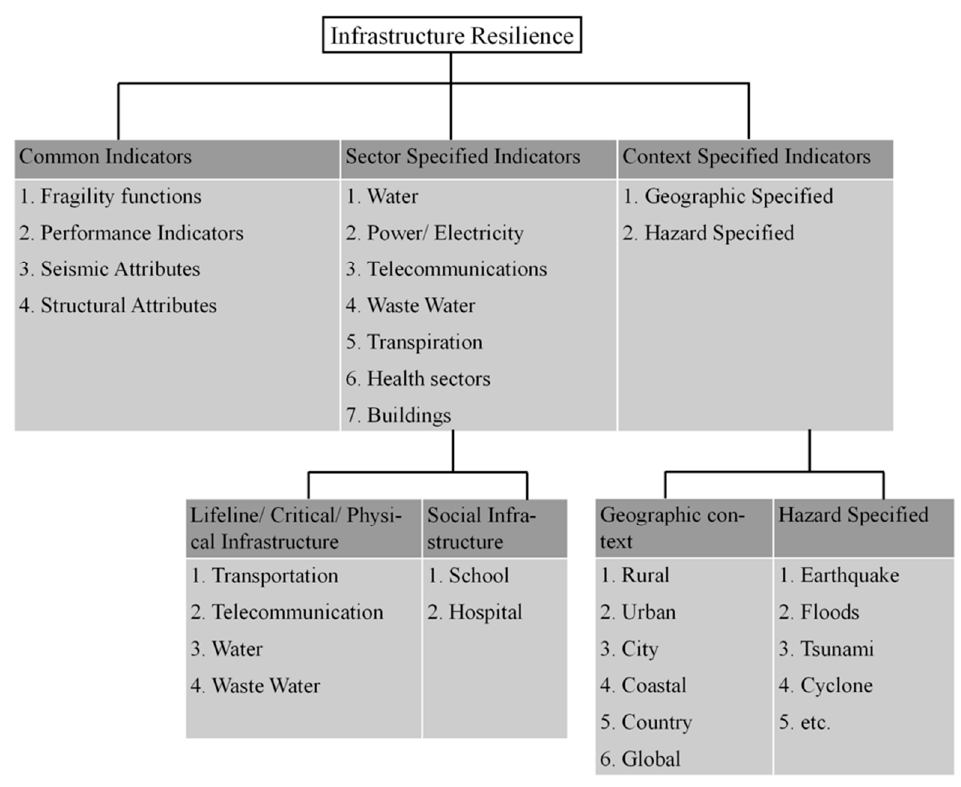
Figure 5. Summary of infrastructure resilience framework development approaches.